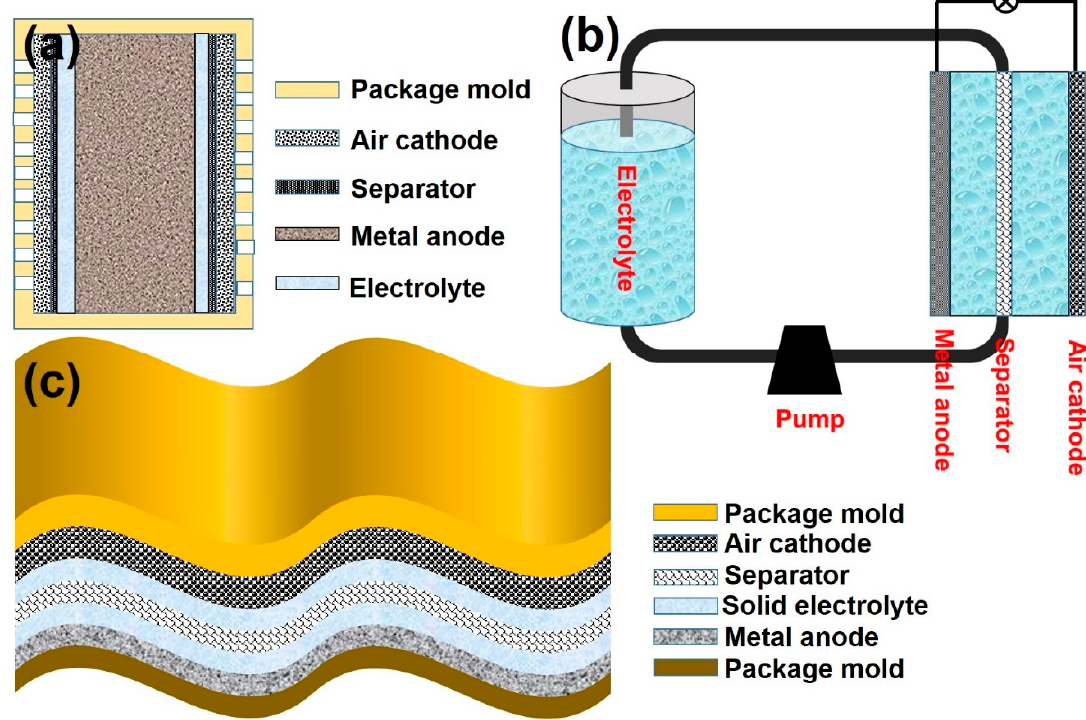
Figure 4. Schematic diagram of different MAB configurations: ( a ) multi-cell static configuration, ( b ) flow battery, and ( c) flexible battery.